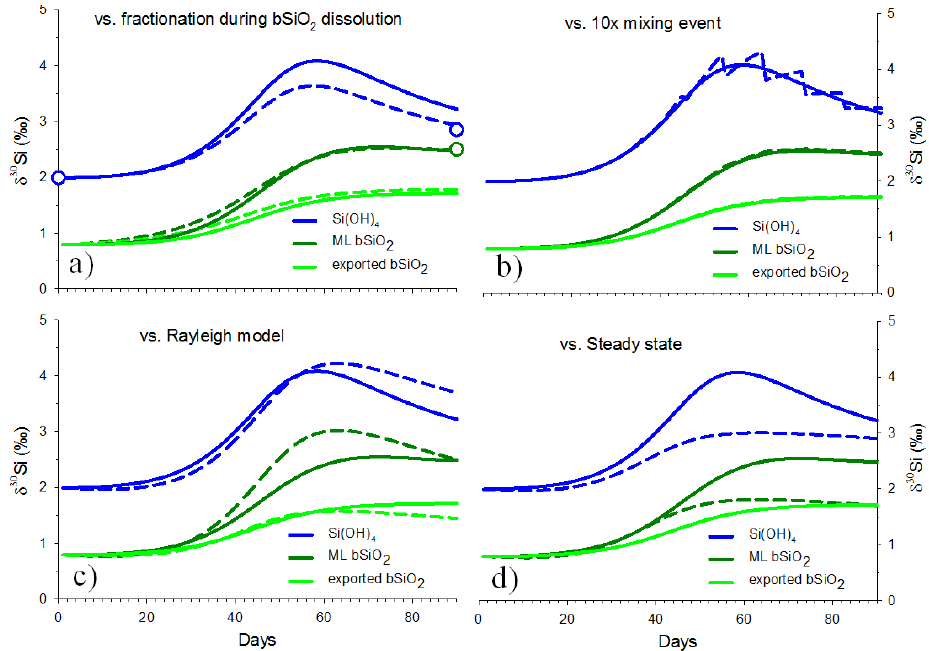
Fig. 6. Model outputs for the case study station in the PFZ. Panel (a) simulated δ 30 Si values for Si(OH) 4 , ML bSiO 2 , exported bSiO 2 without (full lines) and with (dashed lines) bSiO 2 dissolution isotopic fractionation ( 30 ε = − 0 . 55‰). The initial and final estimations are indicated using empty dots with the corresponding colors (Table 2). Panel (b) simulated δ 30 Si values for Si(OH) 4 , ML bSiO 2 , exported bSiO 2 with continuous Si-supply (full lines) and 10 mixing events (dashed lines). (c) Comparison between the simulated δ 30 Si values (full lines) and Rayleigh model outputs (dashed line). For the Rayleigh model, ML bSiO 2 is the instantaneous product (sensu Rayleigh) and exported bSiO 2 the accumulated product (sensu Rayleigh). (d) Comparison between the simulated δ 30 Si values (full lines) and the Steady State model outputs (dashed